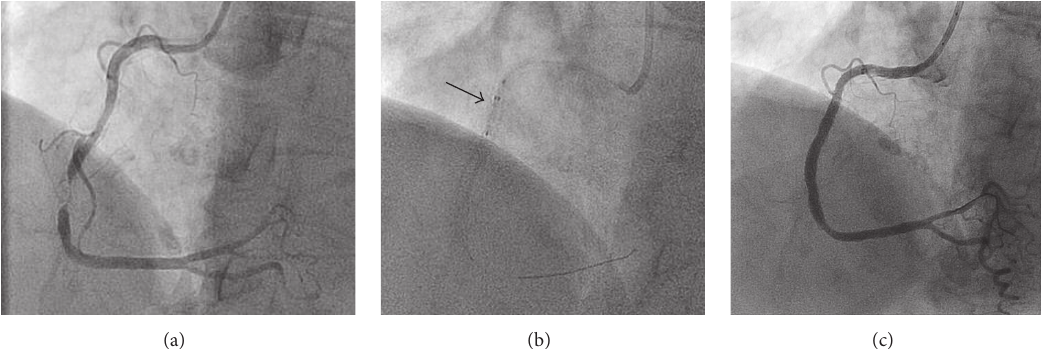
Figure 5: (a) Mid RCA severe lesion with moderate ISR of the proximal vessel. (b) Advancement of the GuideLiner through previously stented segment using GBAT; black arrow indicated the GuideLiner as it passes the lesion with an inflated balloon. (c) Successful postdilation and great angiographic